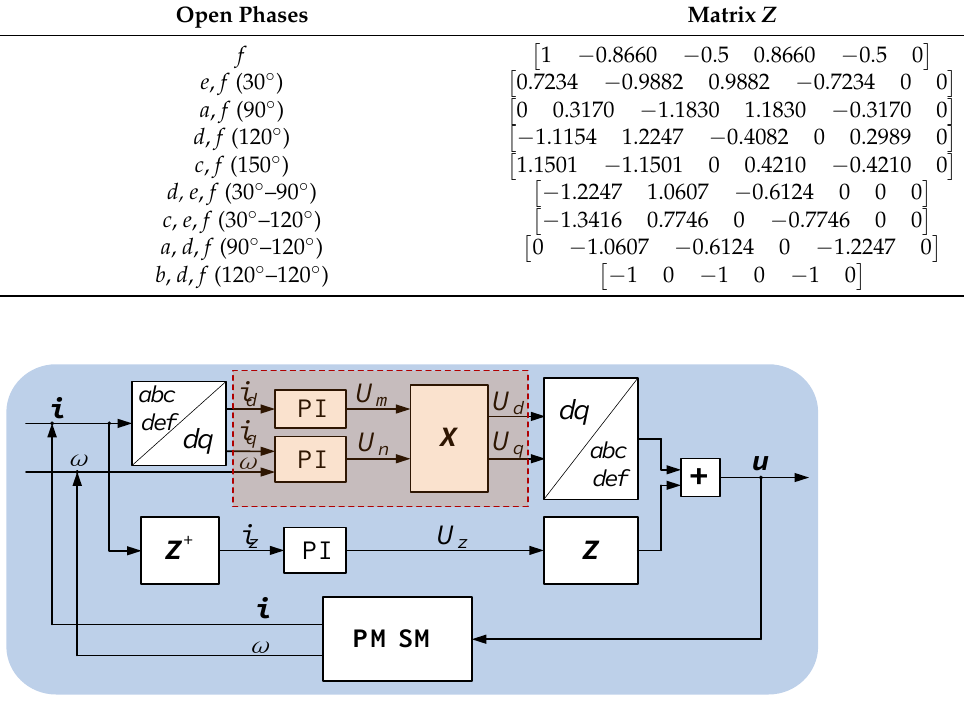
Figure 5. Tolerant control strategy with harmonics elimination.